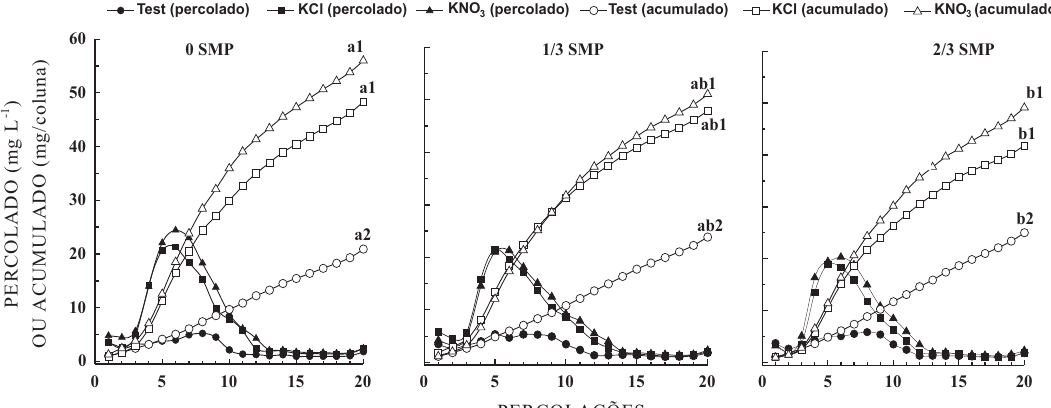
Figura 2. Concentração de potássio percolado e acumulado em função da adição de doses de calcário (0, 1/3 e 2/3 da recomendação do método SMP para pH-H O 6,0) combinadas com sais de potássio aplicados na 2 superfície de um Cambissolo Húmico. Médias acumuladas seguidas pela mesma letra ou número não diferem significativamente pelo teste de Tukey a 5 %; letras comparam os sais entre as doses de calcário, e números comparam os sais dentro de cada dose de calcário.